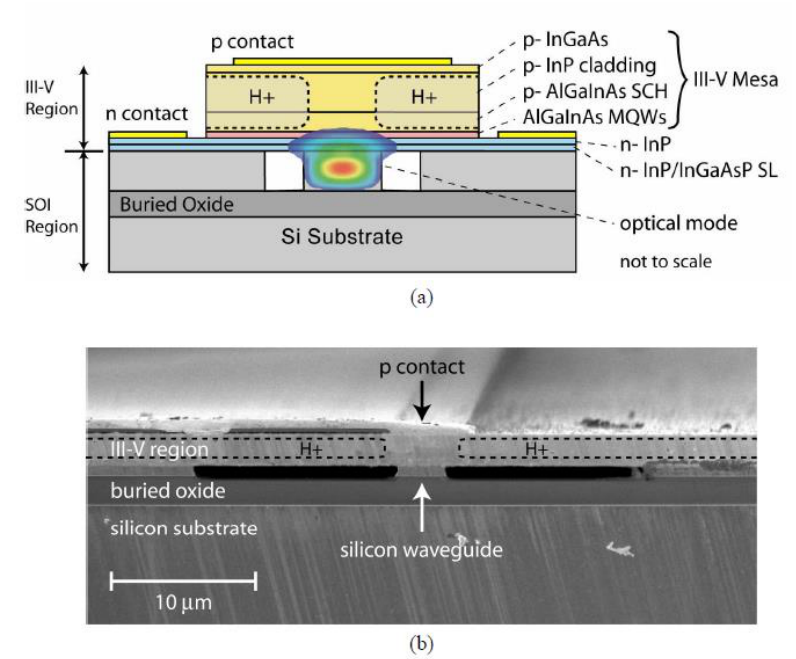
Figure 6. ( a ) Cross-sectional schematic of hybrid Si evanescent platform; ( b ) SEM image of hybrid Si evanescent platform [72] (Reproduced with permission from Fang et al. , Opt. Express ; published by OSA,